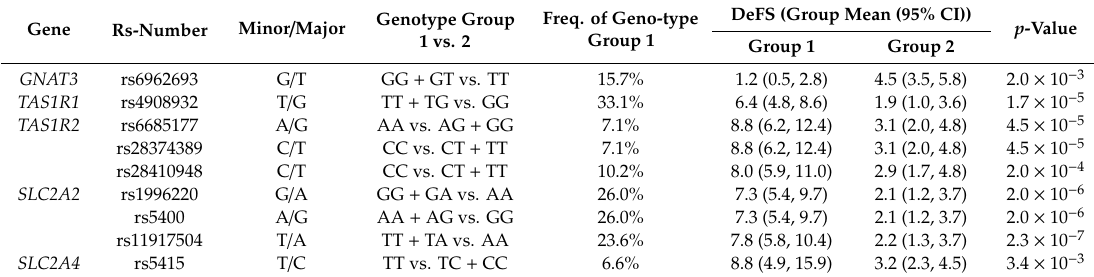
Table 4. Sweet taste and sugar intake associated genetic polymorphisms and caries status. Associations were tested in generalized linear models with total number of decayed and filled tooth surfaces (DeFS) as dependent variable and each of the SNPs as predictors. All models included tooth brushing frequency as covariate. All tests were controlled by the Benjamini and Hochberg procedure, and models where the p -value passed multiple correction using Benjamini and Hochberg false discovery rate of 0.05 are presented. Variants with minor allele count < 5 were excluded. Mean (95% CI) values for the phenotype are given for each genotype